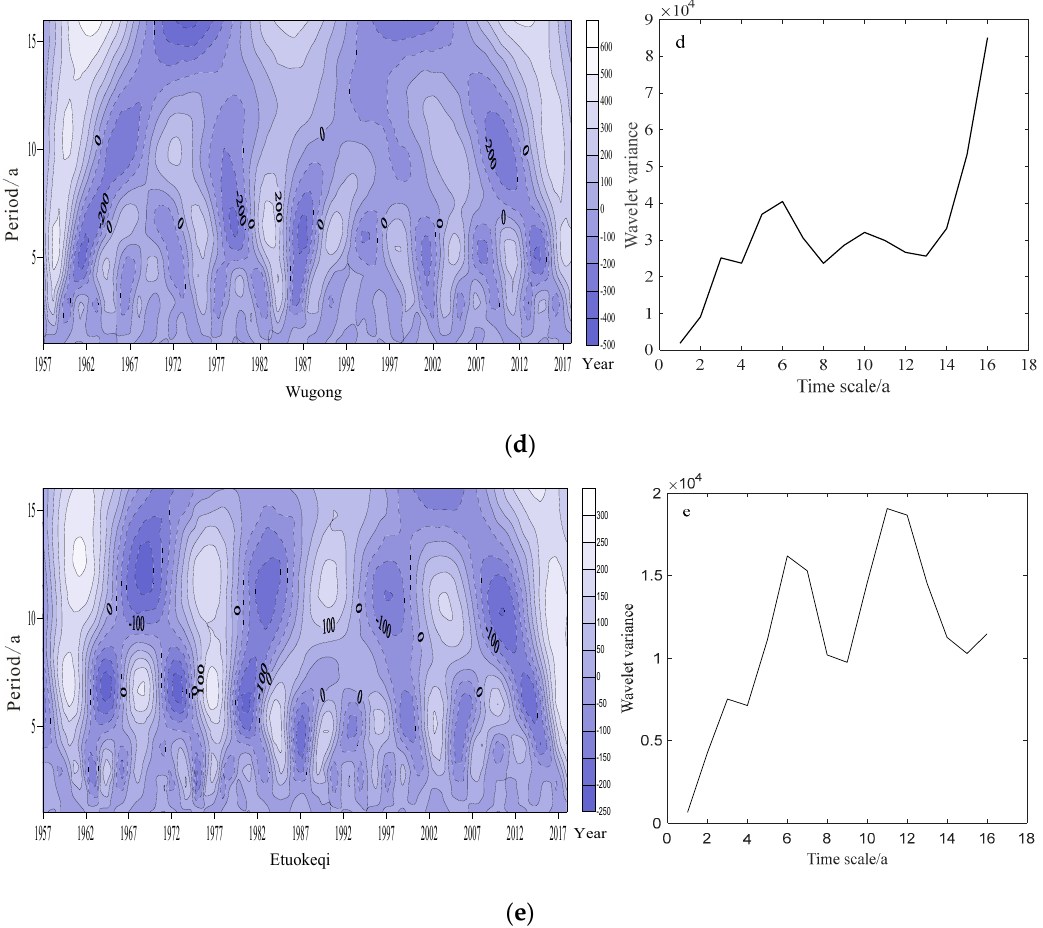
Figure 6. Transform coefficient of Morlet wavelet real contour and wavelet variance of Taiyuan ( a ) Wuqi ( b ), Lanzhou ( c ), Wugong ( d ), and Etuokeqi ( e ) stations.